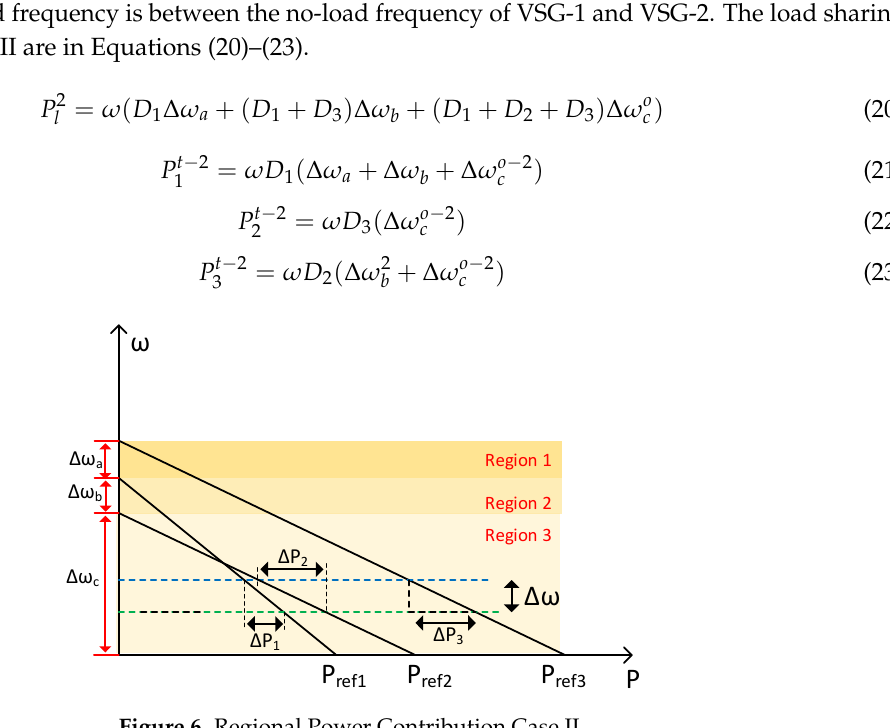
Figure 6. Regional Power Contribution Case II.